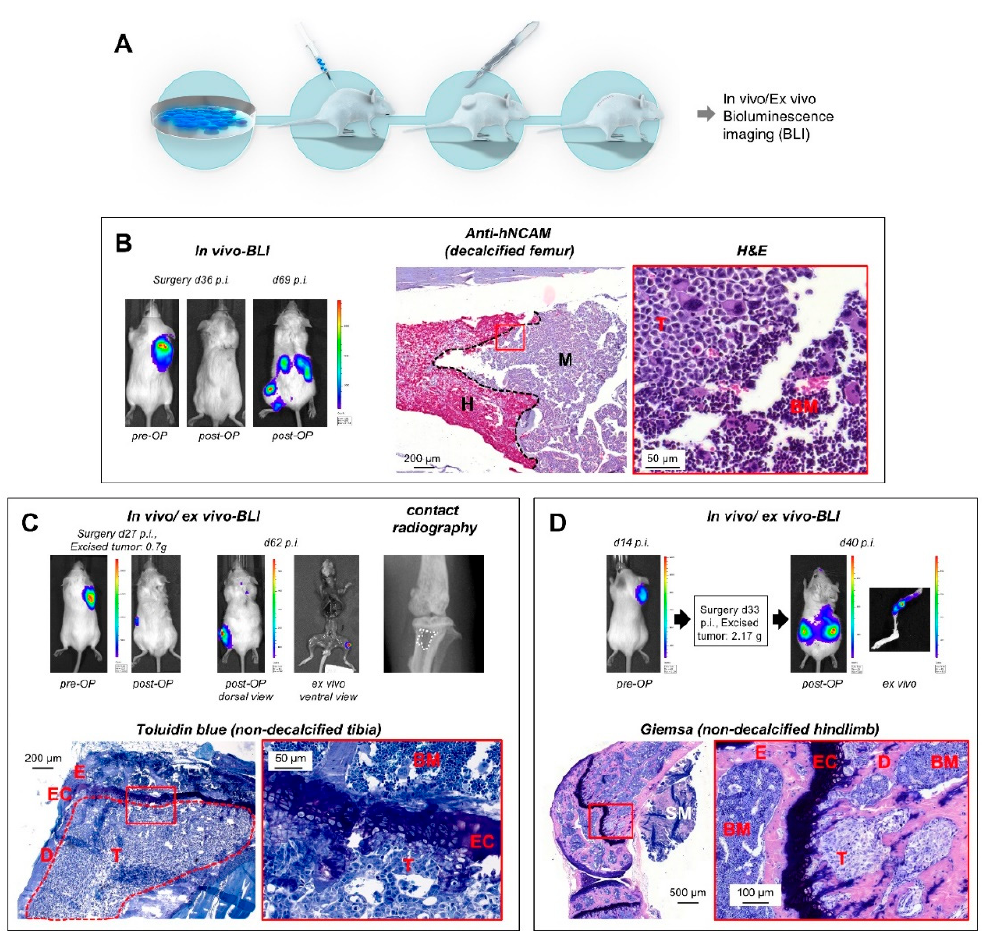
Figure 2. Modeling spontaneous BM metastasis formation after s.c. engraftment of xenograft primary tumors (PTs) . ( A ) Use of Luc2 -expressing human cancer cell lines, surgical resection of established primary tumors, and post-surgical monitoring of metastatic outgrowth by bioluminescence imaging (BLI). ( B ) In a human small cell lung cancer (SCLC) model (H69AR- Luc2/mCherry ), metastases became apparent by in vivo BLI in the retroperitoneal region and the left hindlimb 69 days after tumor cell injection (33 days post-OP). Anti-hNCAM immunostaining demonstrated the human origin of the metastatic cells in the murine BM, which can be discriminated by their different morphology as well (H&E stain). ( C ) Importantly, in vivo BLI signals obtained 62 days after injection (35 days post-surgery) of H69AR- Luc2 / mCherry cells remain visible for up to 45 min ex vivo (top, ventral view). This lesion caused a radiographically detectable osteolysis (top right) and was due to a large bone metastasis infiltrating the entire tibia diaphysis (bottom). Based on this observation, ex vivo BLI of isolated bones was henceforth performed, even if no bone-related BLI signals were detectable in vivo. As shown in ( D ), early metastatic colonies of the BM became apparent by this procedure, for example, 40 days after injection of tumor cells (7 days post-OP, LAN-1- Luc2 / mCherry neuroblastoma model). BLI = bioluminescence imaging; p.i. = post injectionem; hNCAM = human neuronal cell adhesion molecule; H = human; M = murine; E = epiphysis; EC = epiphyseal cartilage; D = diaphysis; SM = skeletal muscle; T = tumor; BM = murine bone marrow.